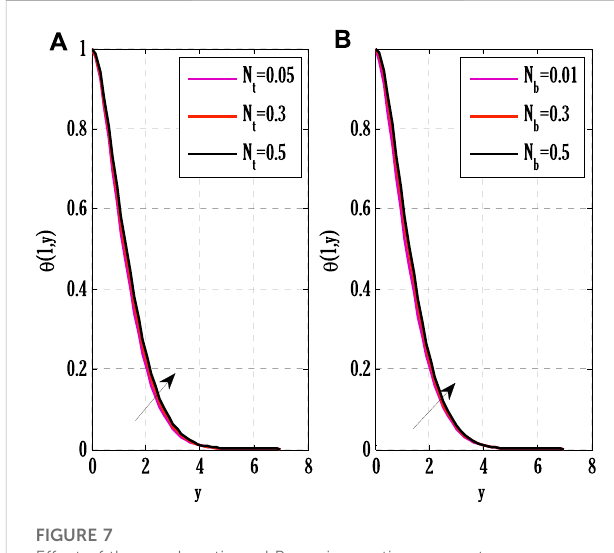
FIGURE 7 Effect of thermophoretic and Brownian motion parameters on temperature pro fi le using N t (cid:2) 150 , N y (cid:2) 45 , L (cid:2) 7 , t f (cid:2) 1 , E c (cid:2) 0 . 9 , λ 1 (cid:2) 0 . 1 , λ 2 (cid:2) 0 . 1 , R d (cid:2) 0 . 1 , P r (cid:2) 1 , S c (cid:2) 1 , R d (cid:2) 0 . 1 , M (cid:2) 0 . 9 , β (cid:2) 3 , F r (cid:2) 1 . 5 , μ